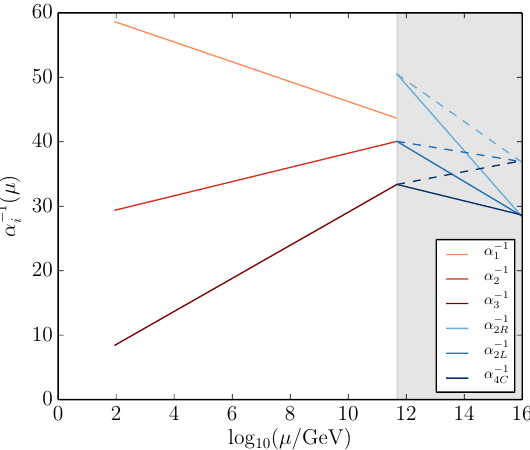
Figure 1 . Gauge coupling uni(cid:12)cation in the minimal model (dashed curves) and extended model (solid curves). Below M I , the RG running is the same. The shaded region, from M I to M GUT , denotes the energy interval of the intermediate gauge